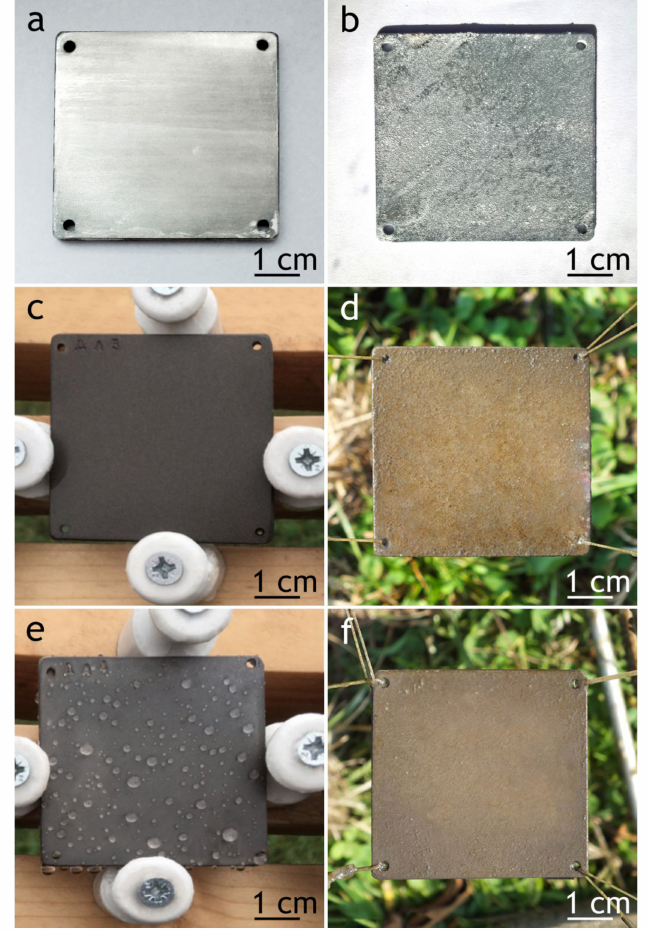
Figure 21. Bare alloy ( a , b ), PEO ( c , d ) and composite coatings ( e , f ) after 30 days of atmospheric exposure and marine immersion,